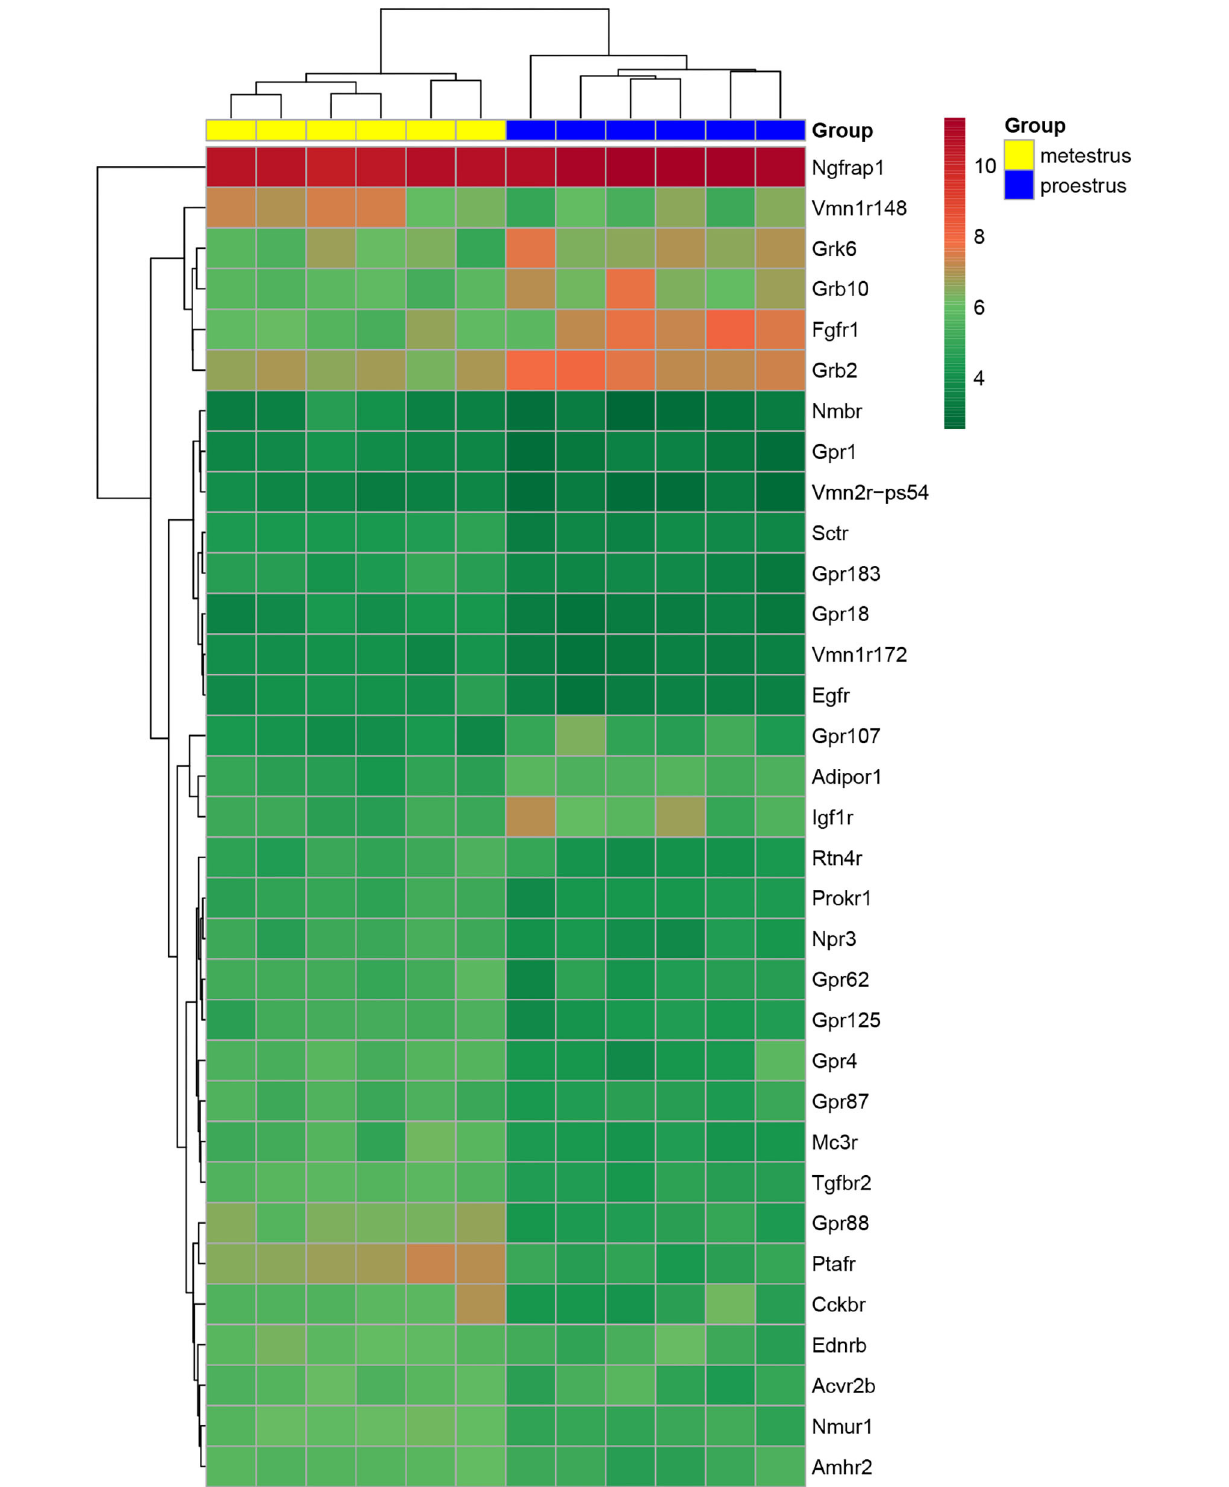
Frontiers in Molecular Neuroscience |